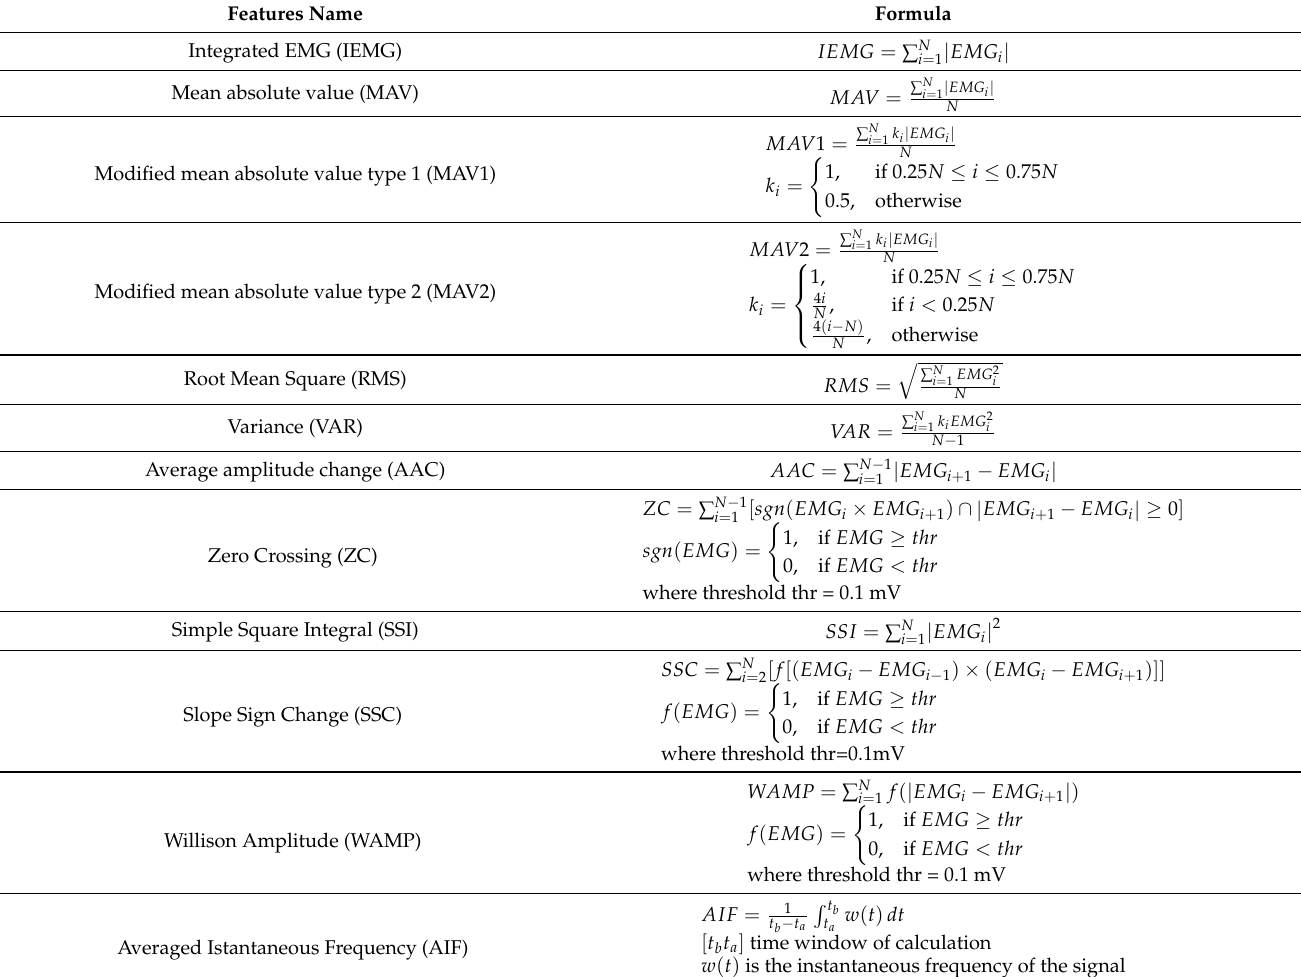
Table 1. Mathematical equations of the tested features for an EMG signal segment of length N